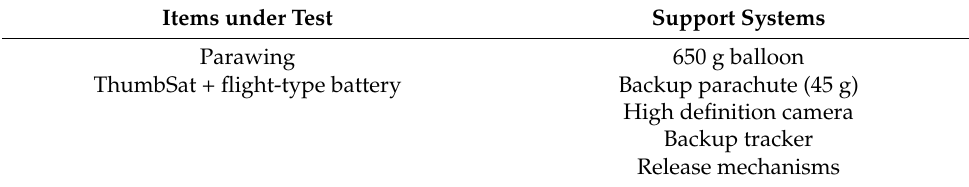
Table 1. List of components of the tested payload.